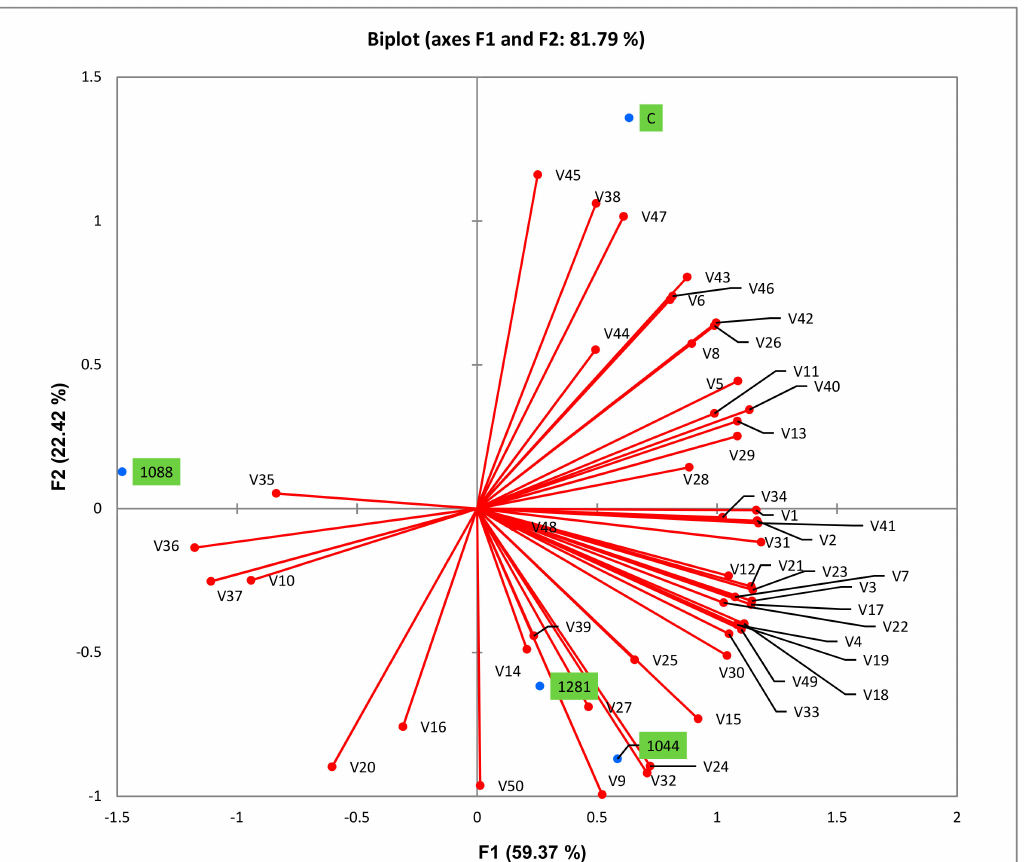
Figure 3. Principle component analysis according to yeast strain, based on volatile compositions of wines. Note: C = wine fermented with control strain; 1044 = wine fermented with autochthonous 1044 yeast; 1088 = wine fermented with autochthonous 1088 yeast; 1281 = wine fermented with autochthonous 1281 yeast; V = variable—the numbers that correspond to each compound are shown